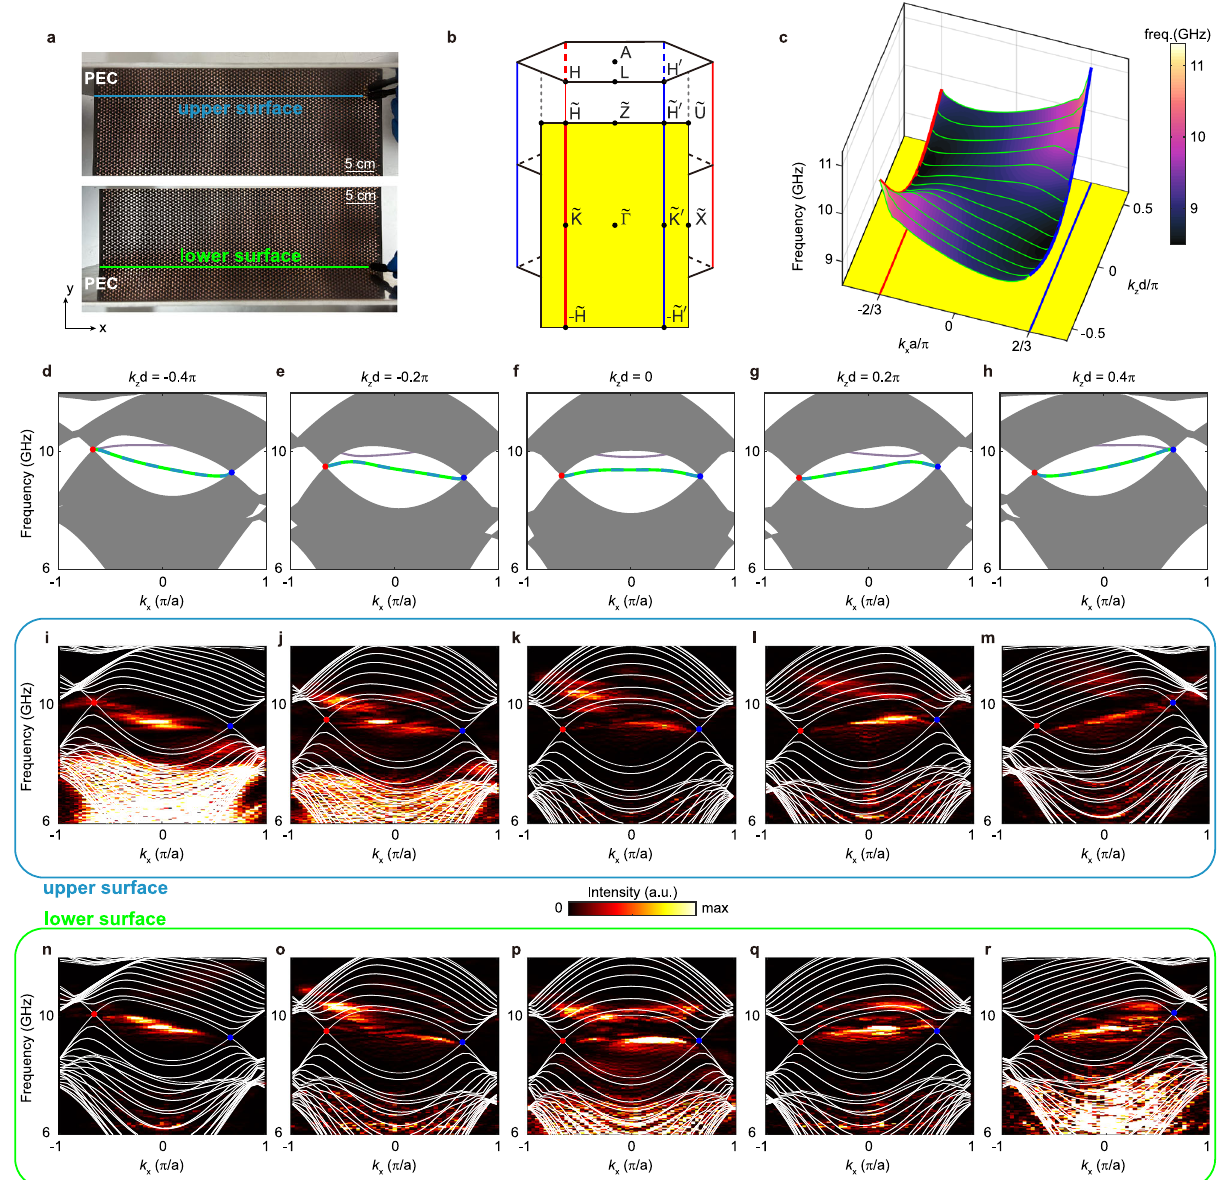
Fig. 4 | Experimental observation of twisted ribbon surface state. a Experimentalsetupforprobingthesurfacedispersion.Theupper/lowersurfaceis covered with an aluminum plate (deemed a PEC in the microwave regime). The probe antenna scans the crystal surface hole-by-hole. b Bulk Brillouin zone and its surface projection (yellow plane). c Simulated surface dispersion in the shape of a twistedribbon.Forclarity,theprojectedbulkbandsareconcealed,leavingonlythe